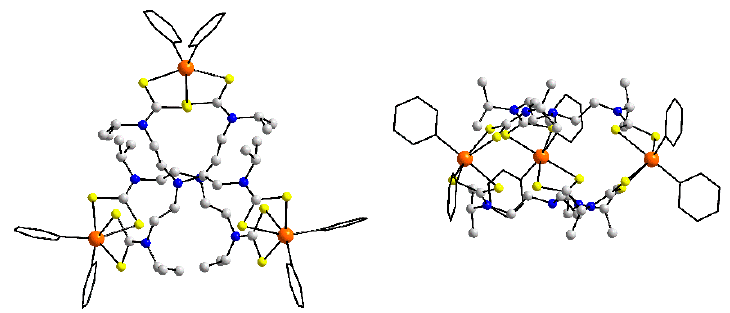
Figure 19. Two views of the molecular structure of (Ph 2 Sn) 3 (L 39 ) 2 in the crystal of 95 .